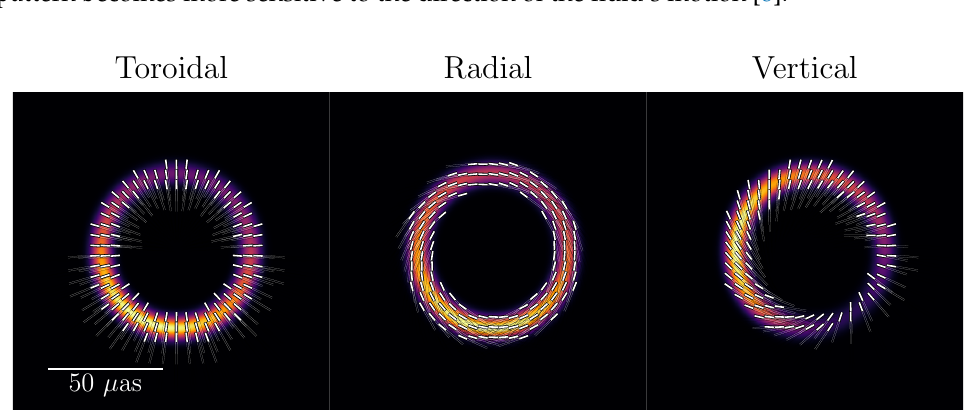
Figure 3. Polarization pattern of a ring of emission around a Schwarzschild black hole threaded with magnetic fields of different geometries: toroidal, radial, and vertical adapted from Figure 3 of [8]. The toroidal and radial magnetic field cases clearly illustrate the fact that synchrotron emission is polarized perpendicular to the magnetic field projected onto the sky. The orientation of the ticks in the vertical field case encodes the direction of the fluid’s motion [8], chosen here to be clockwise on the sky. These maps were computed using the analytic ring model of Narayan et al. [51]. Here, the color map encodes the total intensity, and unlike in Figure 1, the linear polarization ticks do not scale with the polarized